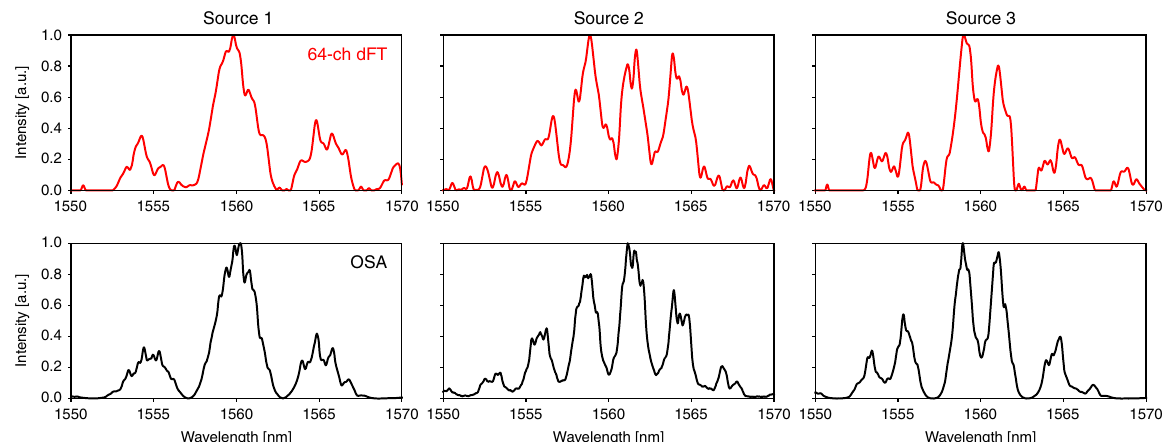
Fig. 4 Broadband signal reconstruction. Three unique light sources with broad spectral features were measured using the dFT spectrometer chip and elastic-D 1 method (top red curves) and compared to measurements by a benchtop optical spectrum analyzer (OSA) (bottom black curves). The three light sources were generated using ampli fi ed spontaneous emission from an erbium-doped fi ber passed through several Mach – Zehnder interferometers (additional information is provided in the